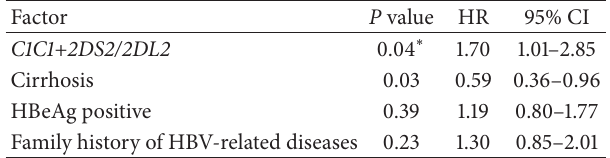
Table 4: Multivariate Cox model survival analysis